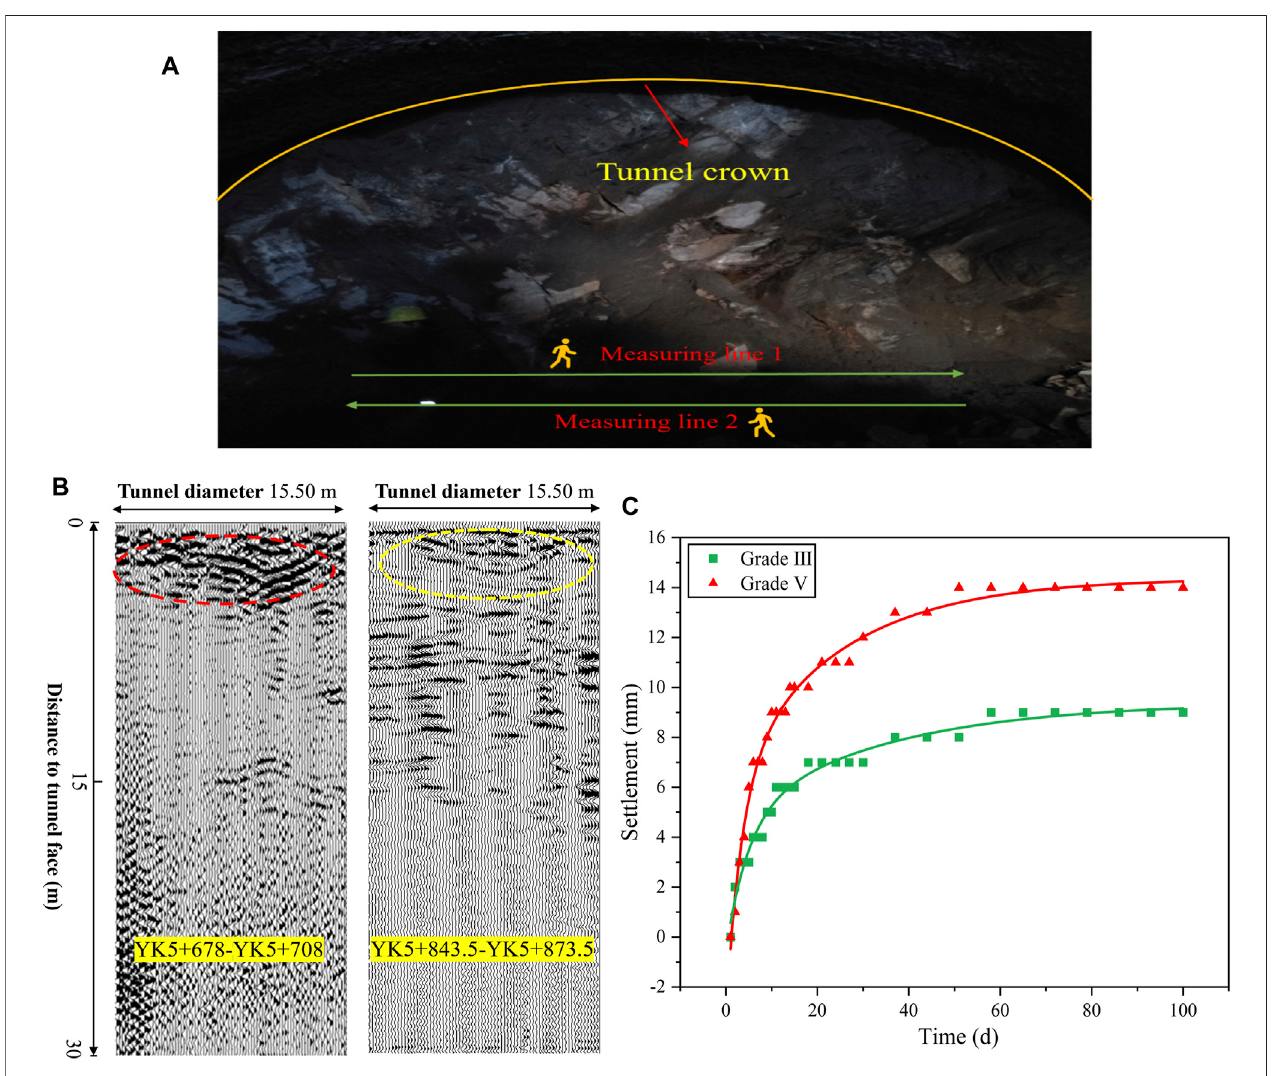
FIGURE 3 | Monitoring data of ground penetrating radar and tunnel crown settlement. (A) Tunnel face and monitoring program of ground penetrating radar at YK5+678. (B) Radar re fl ection images of the tunnel faces and (C) the tunnel crown settlement of grade Ⅲ and Ⅴ surrounding rocks for 100 days.